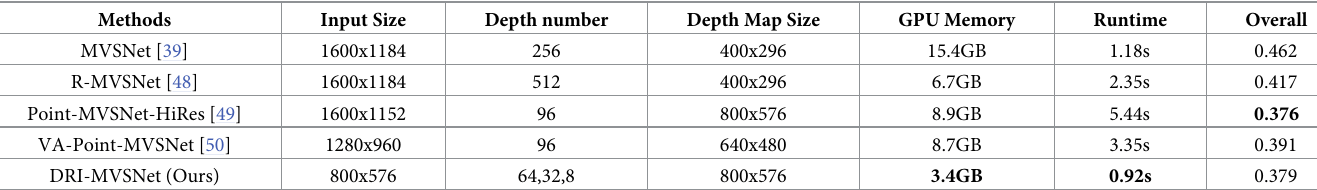
Table 6. Comparisons of time complexity and memory consumption on the DTU